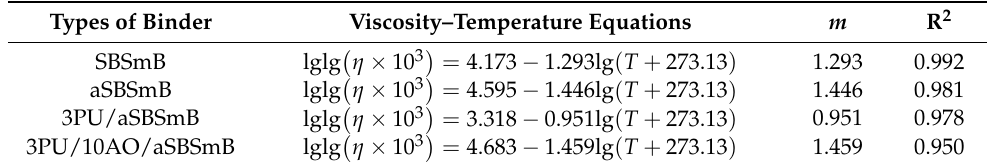
Table 3. Viscosity–temperature curve regression